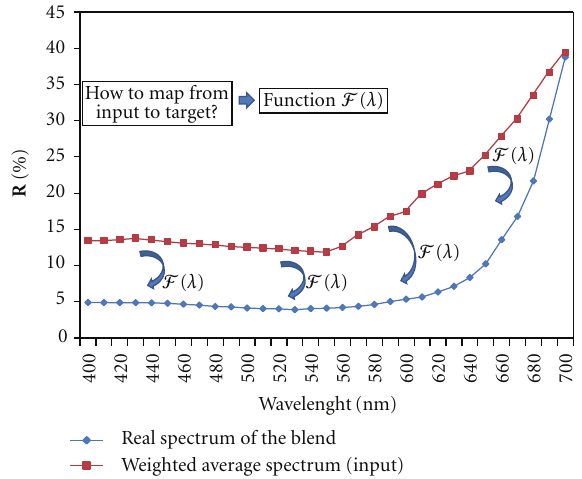
Figure 3: How it is possible to state the real spectrum of a blend when the input consists in a weighted average spectrum? The response is in the transfer function F . The evaluation of this function is the main objective of the “prediction